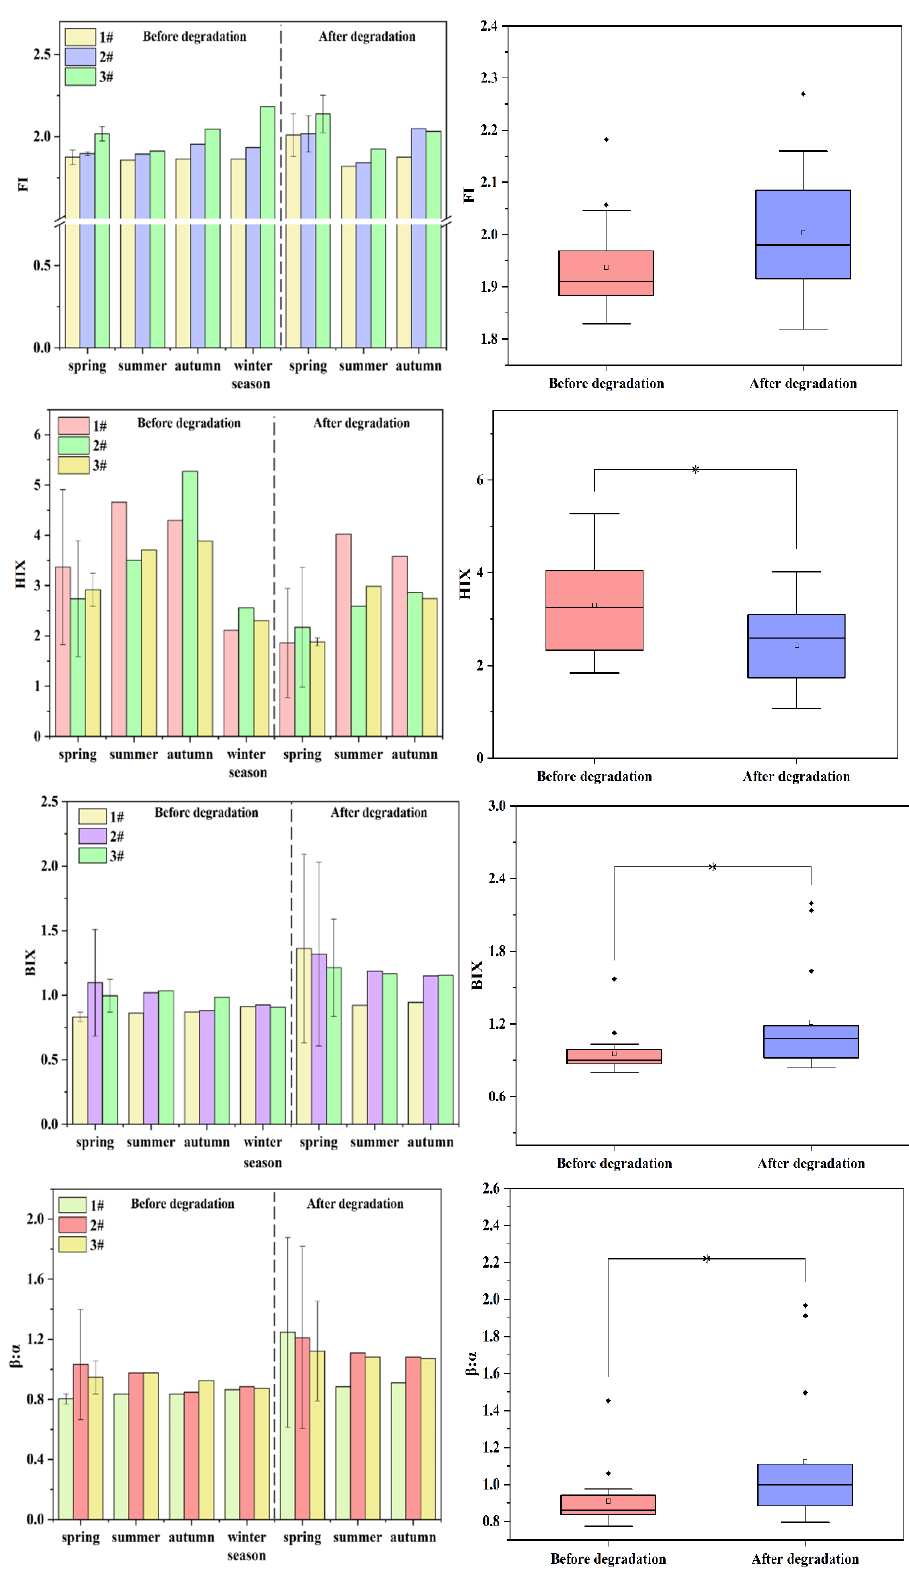
Figure 7. Temporal and spatial changes of FI, HIX, BIX, and β : α in the Shili River. Right panel: The box-plot consists of five numerical points, minimum observation (bottom edge), 25% quantile (Q1), median, 75% quantile (Q3), and maximum observation (top edge). In the box-plot significance analysis, a * means it is significant at the 0.05 alpha level.